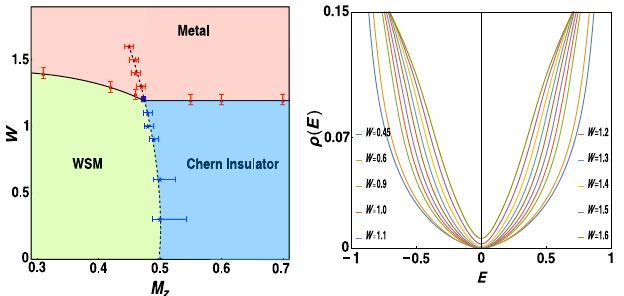
FIG. 2. Left: Numerically obtained phase diagram of a Weyl material residing in the proximity of the WSM-insulator QCP (blue dot for W ¼ 0 ) in the presence of random charge impurities ( W ). The black dashed line represents the phase boundary between these two phases, and the blue square is the multicritical point (MCP) where the WSM, a band insulator (Chern in the present situation), and a metal meet. The density of states at the phase semimetal-insulator phase boundary scales as ϱ ð E Þ ∼ j E j 1 . 5 , as shown in the right-hand panel (see Sec. III for details). With increasing strength of disorder the direct transition between WSM and insulator gets avoided by an intervening metallic phase, where DOS at zero energy is finite (see the right-hand panel). The metallicity sets in through the MCP, where the DOS scales roughly as ϱ ð E Þ ∼ j E j . These findings are in qualitative agreement with the field-theoretic predictions (see Fig.